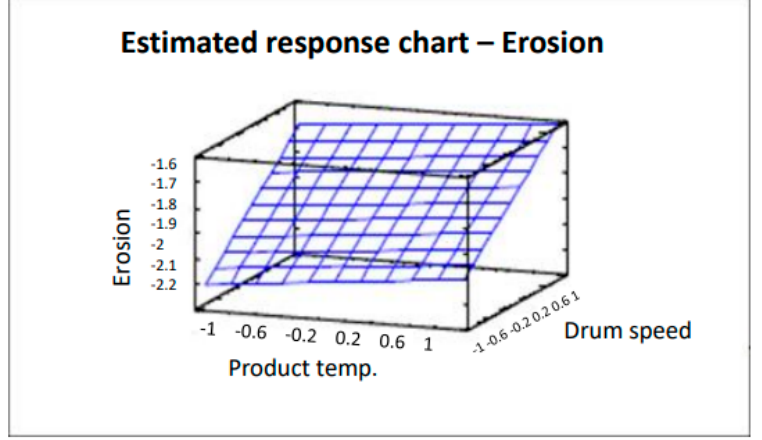
Figure 4. Estimated response chart—Erosion.